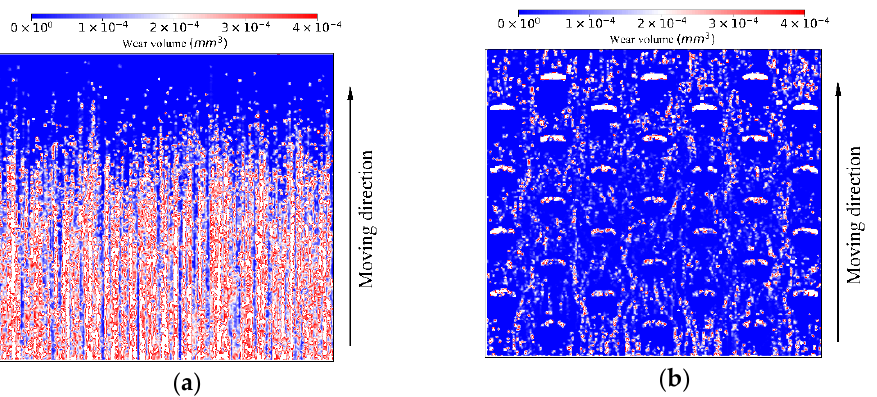
Figure 17. Wear distribution of samples for a scaling factor of 1. ( a ) Flat surface; ( b ) Convex pattern surface.